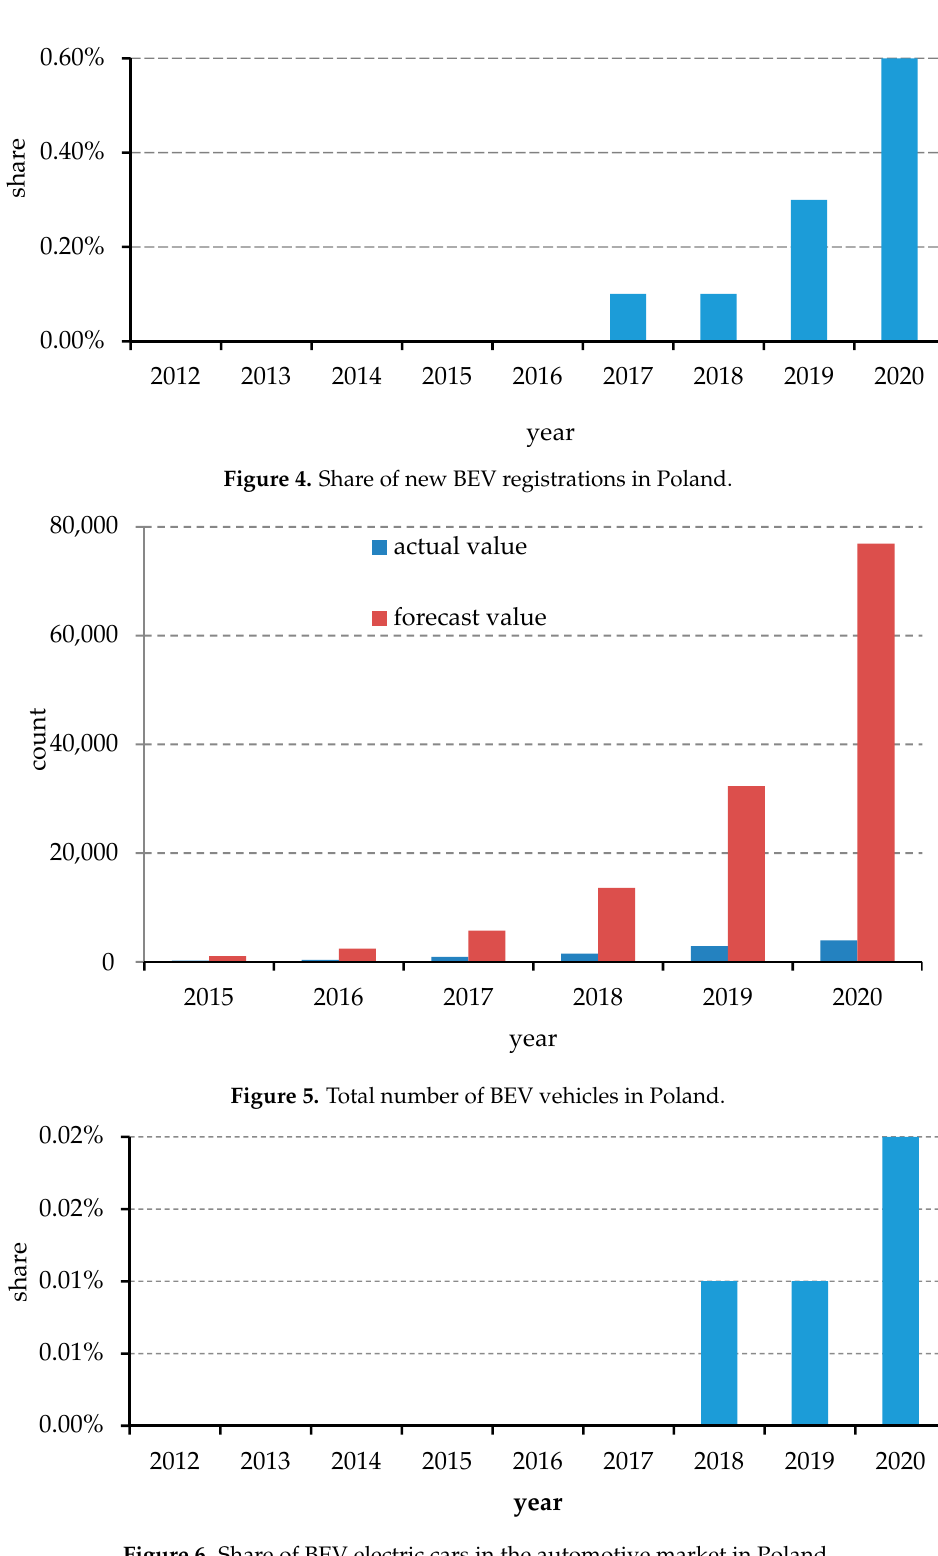
Figure 6. Share of BEV electric cars in the automotive market in Poland.